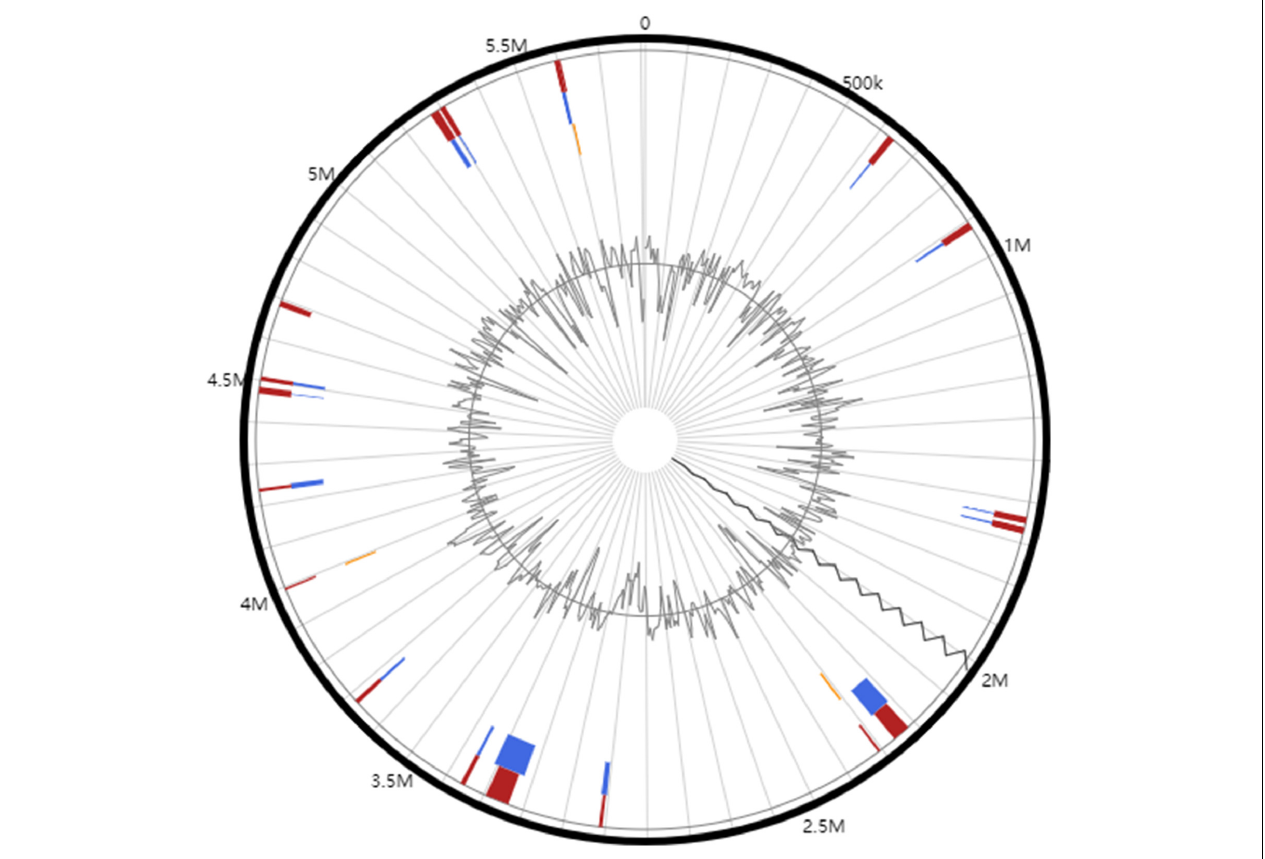
FIGURE 4 | Circular plots of genomic islands identified in R. solanacearum PeaFJ1 genome. The orange- and blue-colored shapes determine the predicted genomic islands as identified by SIGI-HMM (orange) and IslandPath-DIMOB (blue), and red shows the integrated genomic island search